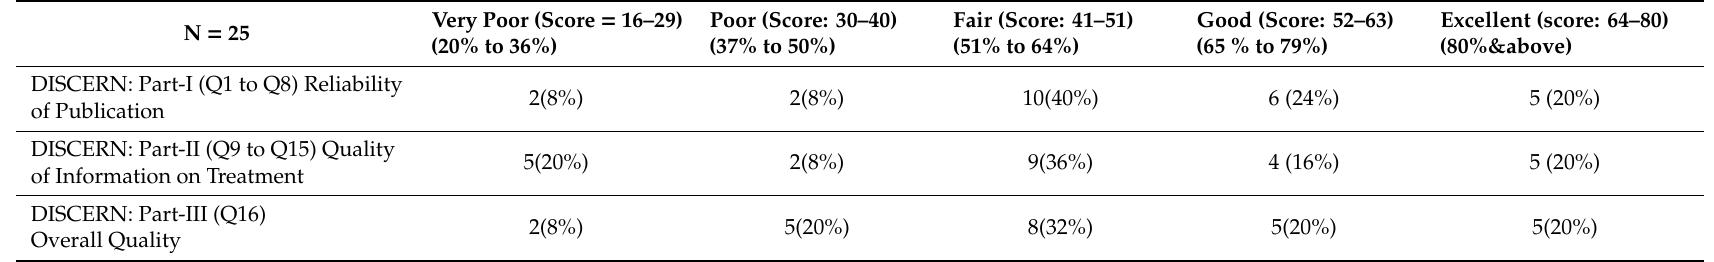
Table 4. Evaluation of all included websites by Group 1 (Health Professional